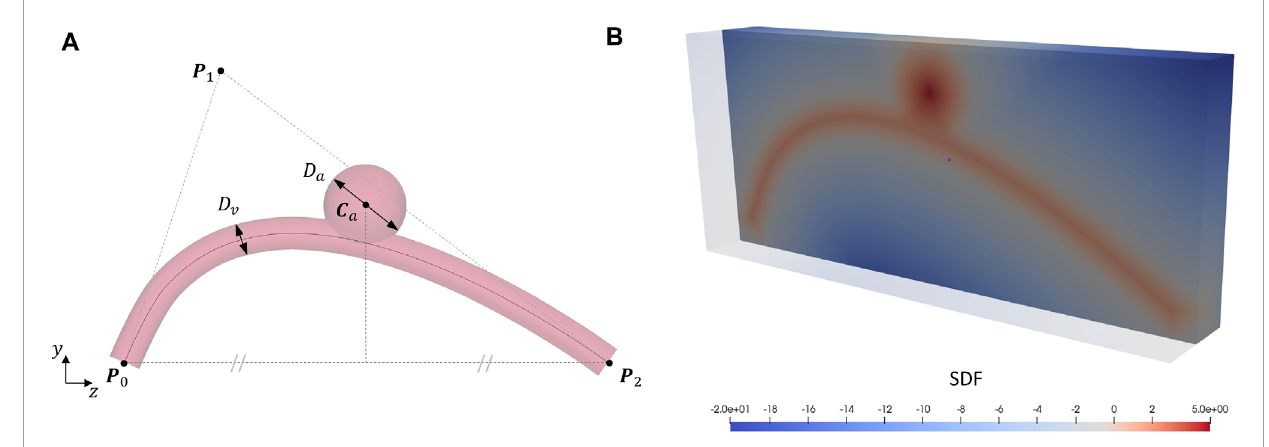
FIGURE 3 Artery and aneurysm modelling. (A) Parametric idealised model of an intracranial artery presenting a saccular aneurysm: Bézier points P 0 , P 1 and P 2 , artery diameter D v , aneurysm diameter D a and centre C a . (B) SDF section of the idealised artery an aneurysm model: the signed distance from a voxel to the surface is reported as a colour map where negative values (blue) correspond to points outside the surface and positive values (red) inside. The